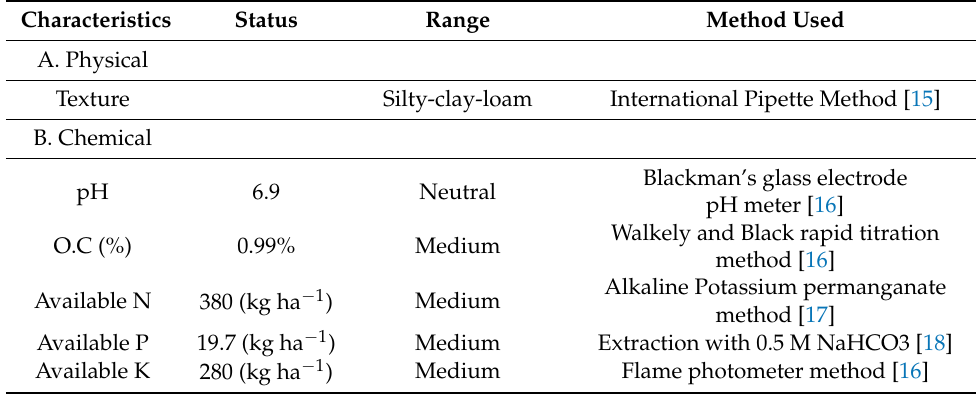
Figure 2. Average weekly meteorological data (2018). Table 1. Initial soil status of experimental